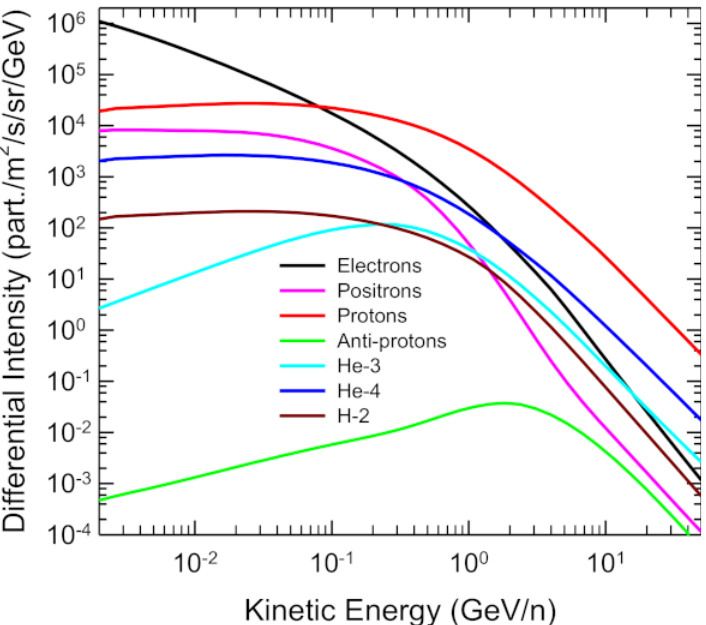
Figure 24. Compilation of computed VLISs shown here for protons, He-3, He-4, deuteron (H-2), electrons, positrons and anti-protons, following the colour coding as indicated in the